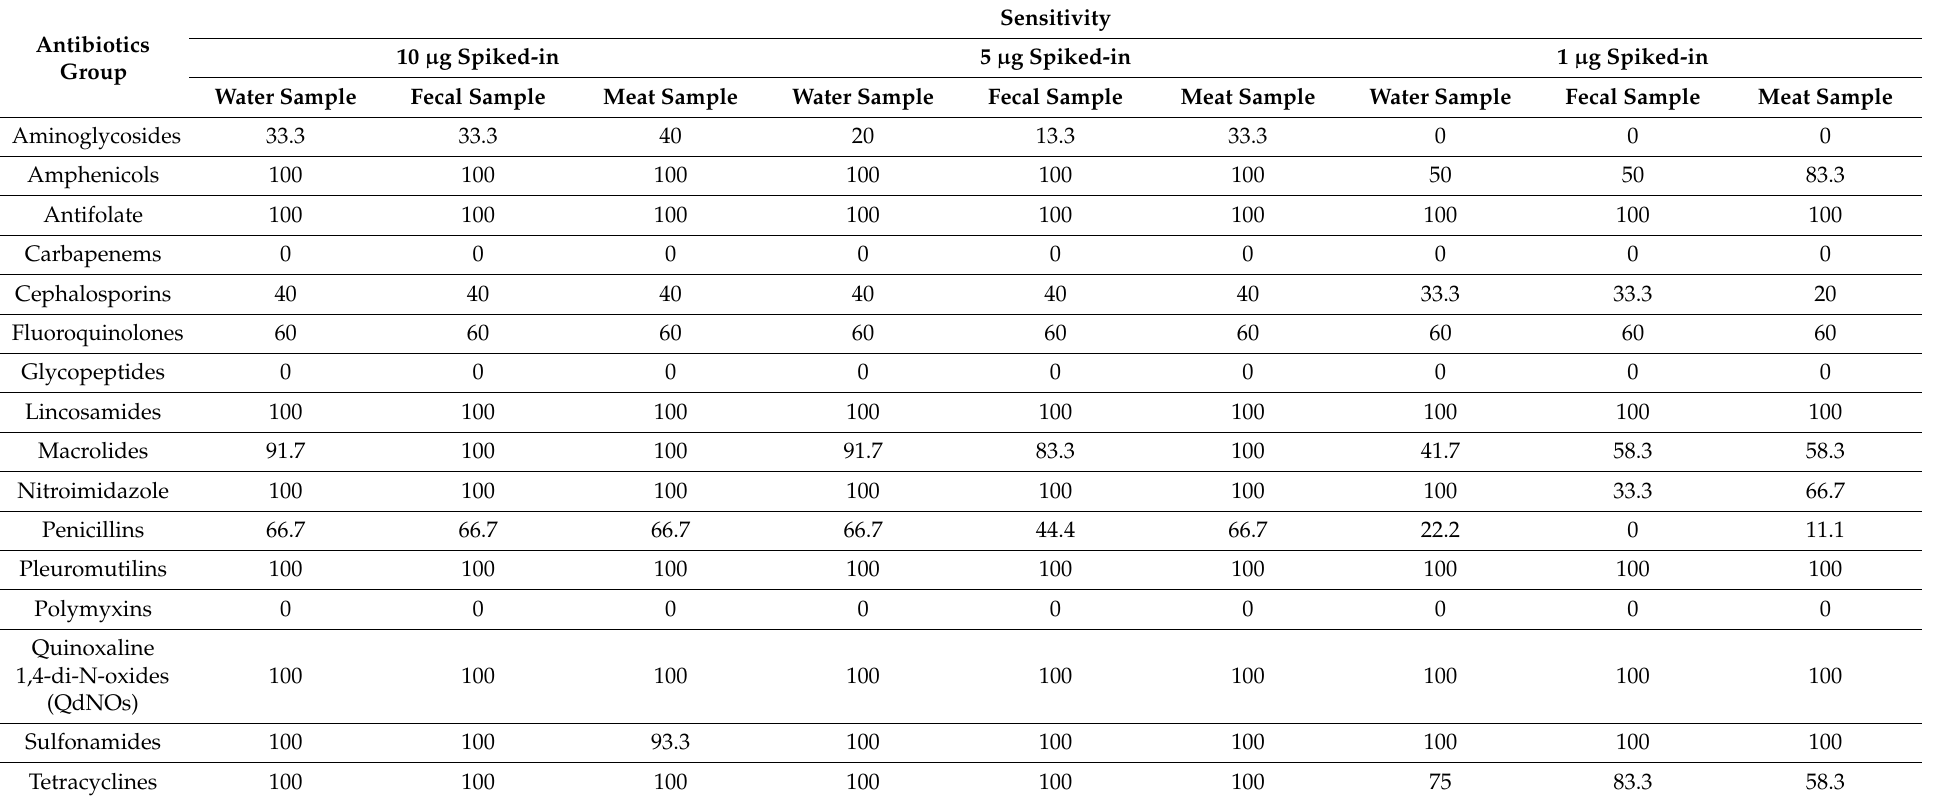
Table 6. Sensitivity of overall protocol for 16 groups of antibiotics at spike-in concentrations of 10 µ g, 5 µ g, and 1 µ